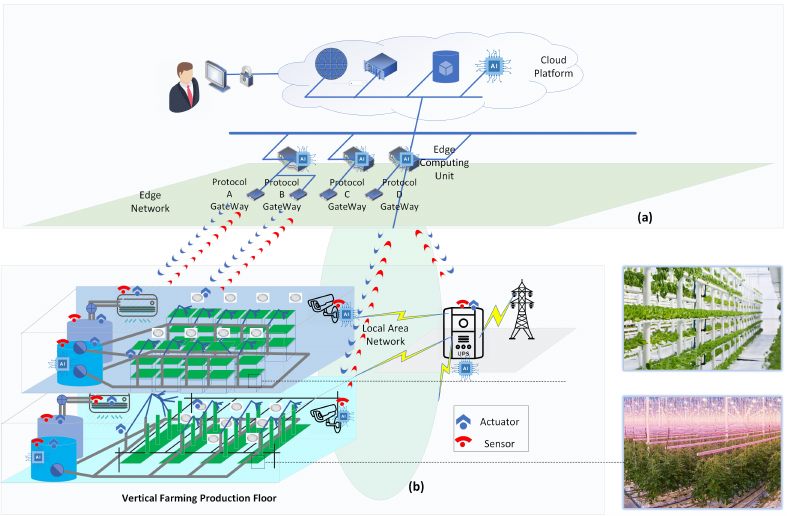
Figure 1. Conceptual architecture of the plant factory from ( a ) industrial informatics perspectives, ( b ) utilization of communication, computing, and